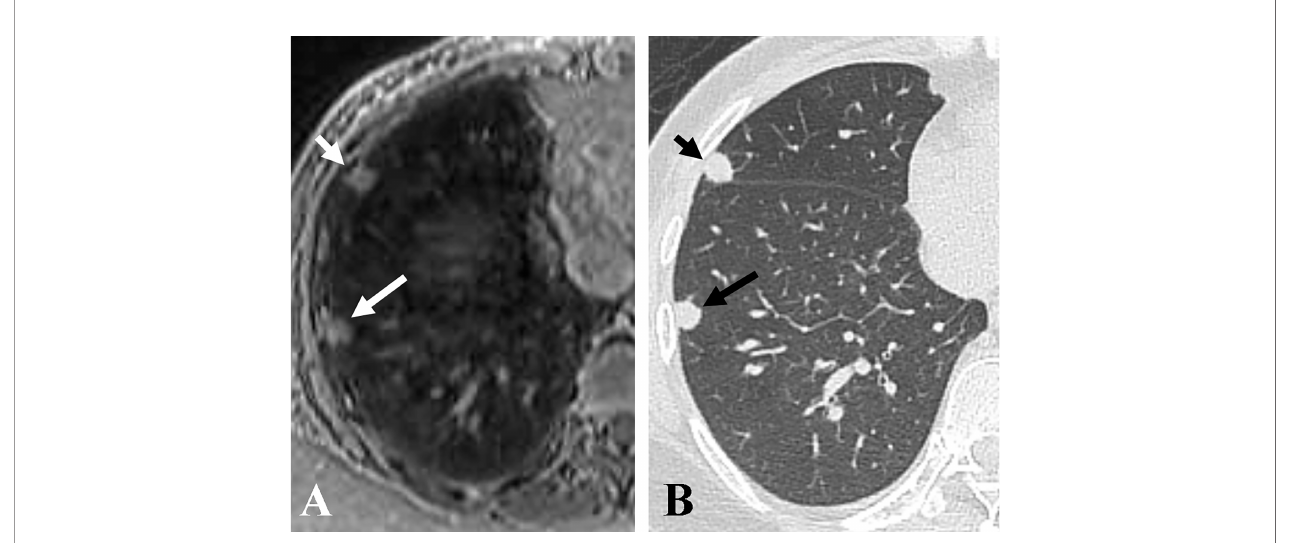
FIGURE 4 | Representative axial images of accelerated spiral 3D UTE (A) and CT (B) , showing nodule size underestimation on MRI compared with CT for pleural- based nodules. The overall image quality rating for spiral 3D UTE image was good. The sizes of two pleural-based nodules in the right middle lobe (short arrows) and right lower lobe (long arrows) were 9.5 mm and 7.7 mm on CT, and 8 mm and 6.2 mm on accelerated spiral 3D UTE, respectively.